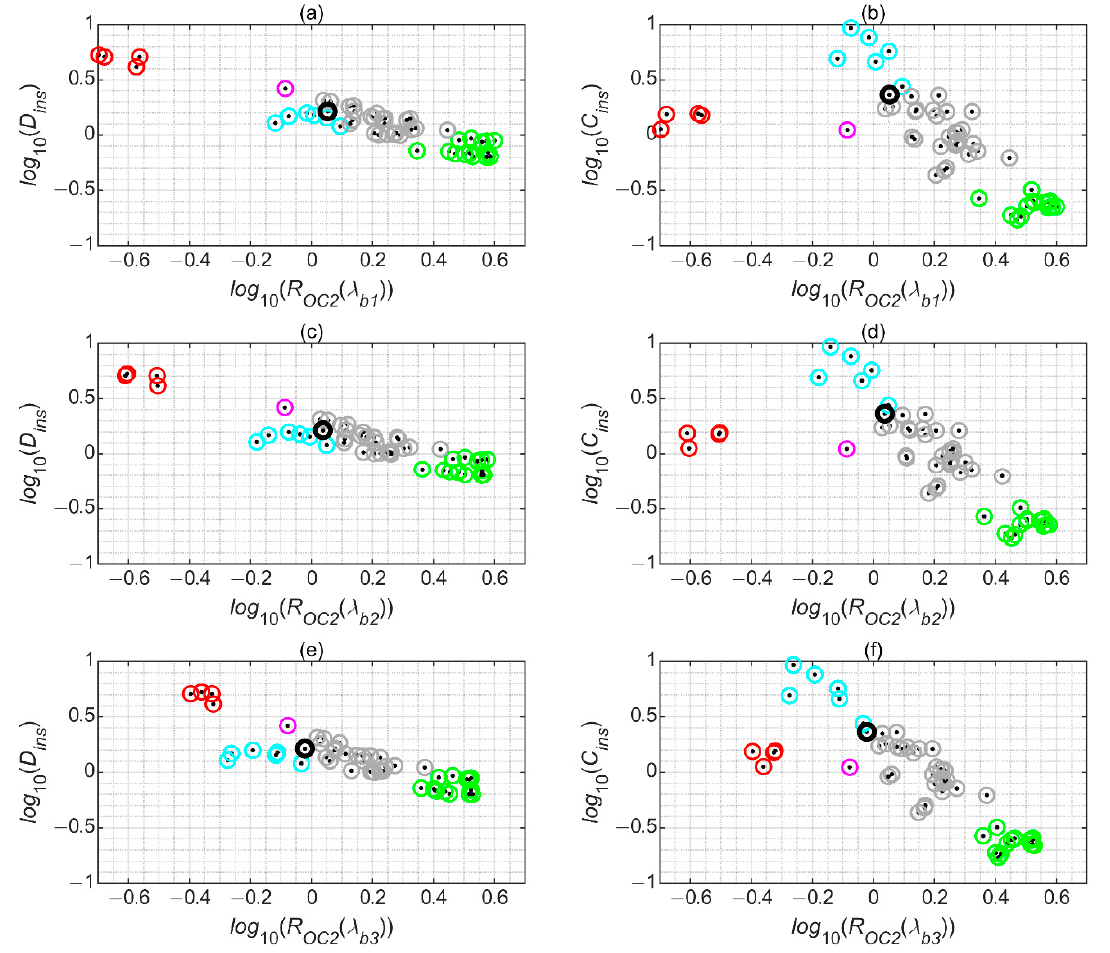
Figure 7. Scatterplots of the logarithms of in situ CDOM content ( D ins ) ( a , c , e ) or chl-a concentrations ( C ins ) ( b , d , f ) versus R OC 2 band ratio index for the first three spectral ranges considered: b1 ( a , b ), b2 ( c , d ), and b3 ( e , f ). Band ratio values were obtained by applying OLCI/S3A spectral response functions to shipborne hyperspectral measurements collected using an ASD radiometer. Table 4. R2L values for comparison between measured in situ CDOM content ( D ins ) and estimated remote sensed CDOM content ( D rs ) calculated using Formula (9) for spectral bands from b1 to b6. Columns with the best results are highlighted in green, and columns with mediocre, but acceptable results are highlighted in yellow. 0.87